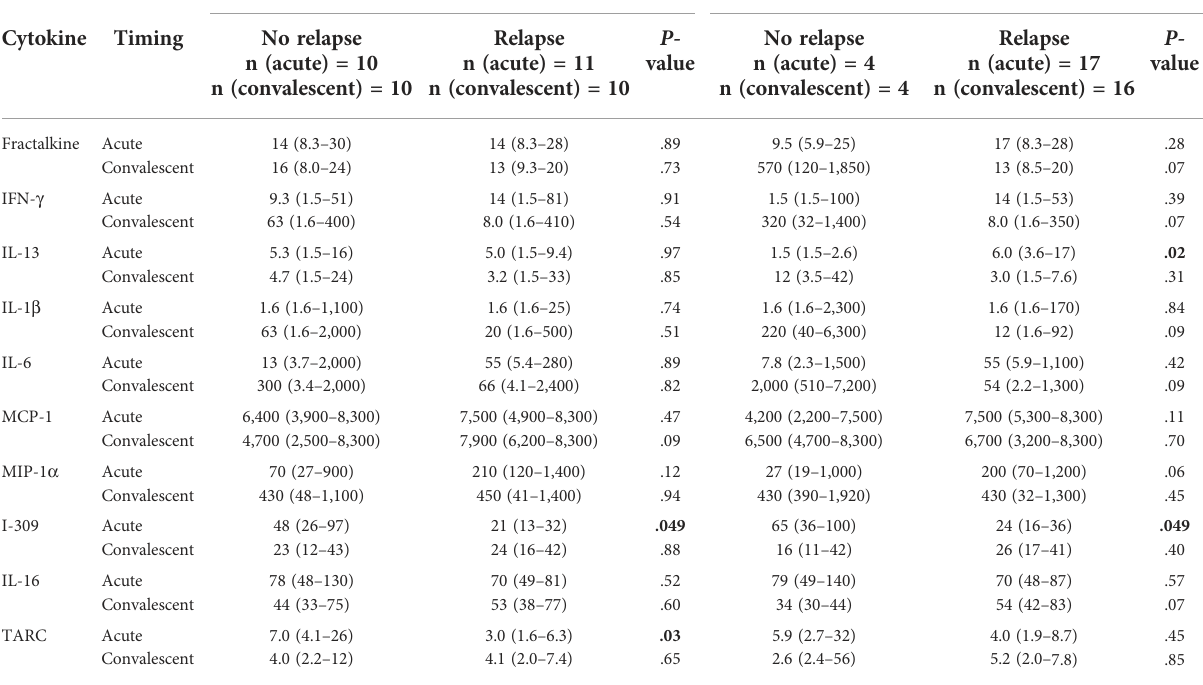
TABLE 4 The association between cytokine expression and